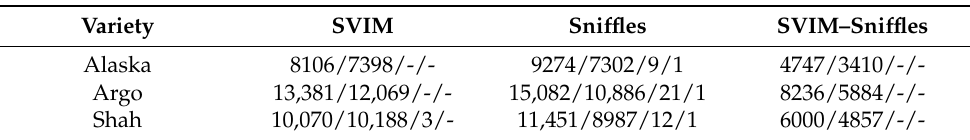
Table 4. Numbers of structural variants in the genome of Alaska, Argo, and Shah varieties. Dele-